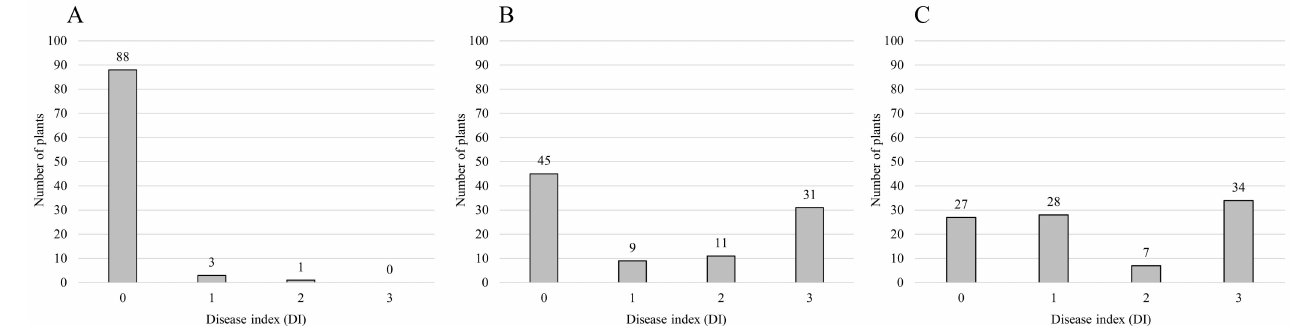
Figure 1. Frequency distribution of disease index (DI) caused by ( A ) a weakly pathogenic isolate ‘IS’, ( B ) a moderately pathogenic isolate ‘HS’, and ( C ) a highly pathogenic isolate ‘HWA’ of Ralstonia solanacearum in three F 2 populations of a resistant pepper cultivar ‘Konesian